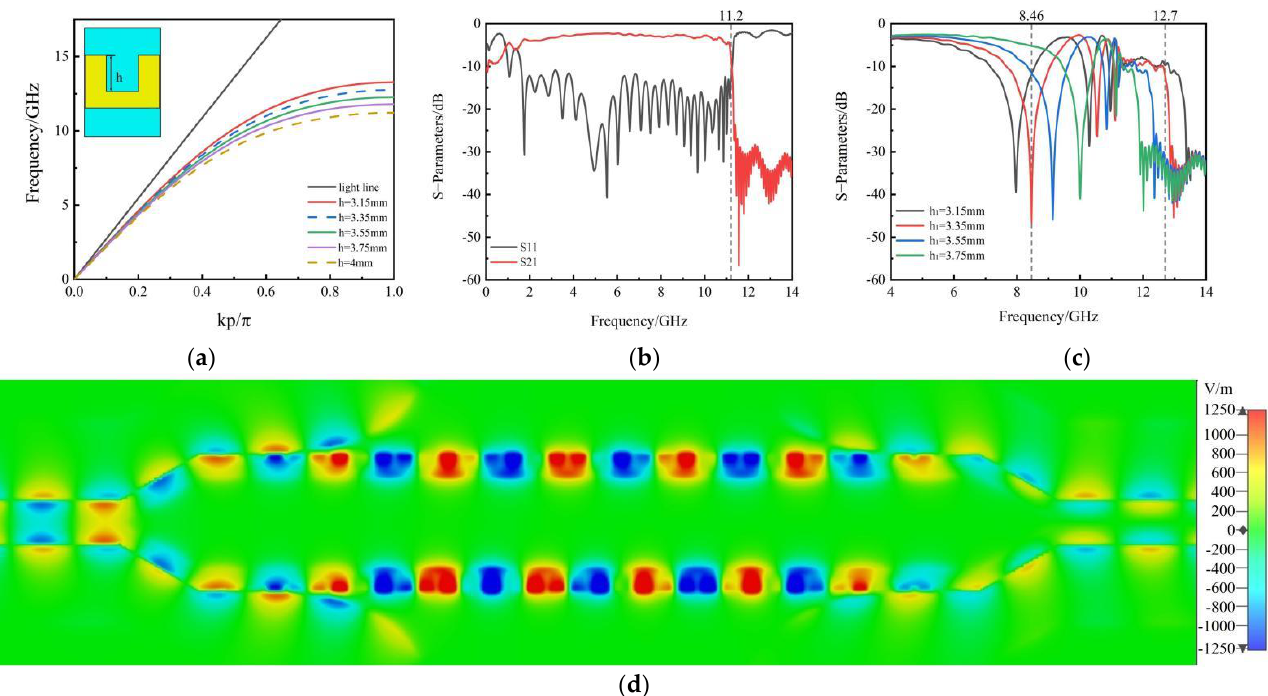
Figure 2. ( a ) Dispersion curves of the U−shaped unit structured with respect to groove depths on the SSPP waveguide; ( b ) Black and red lines represent the reflection (S11) and transmission (S21) coefficients of the SSPP waveguide at h1 = h2 = 4 mm, respectively; ( c ) Simulated S21 amplitude curves of the SSPP-based MZI with h2 = 4 mm, h1 changes from 3.15 to 3.75 mm in steps of 0.2 mm; ( d ) Simulated near-electric-field distribution of the device at 8.46 GHz.